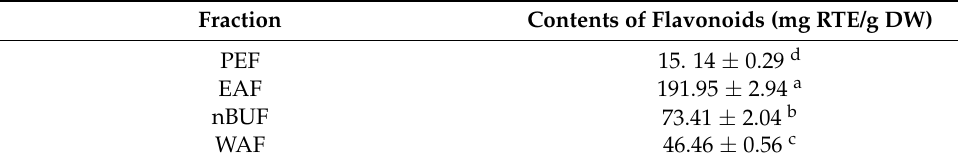
Table 3. The Flavonoids Contents of the Different